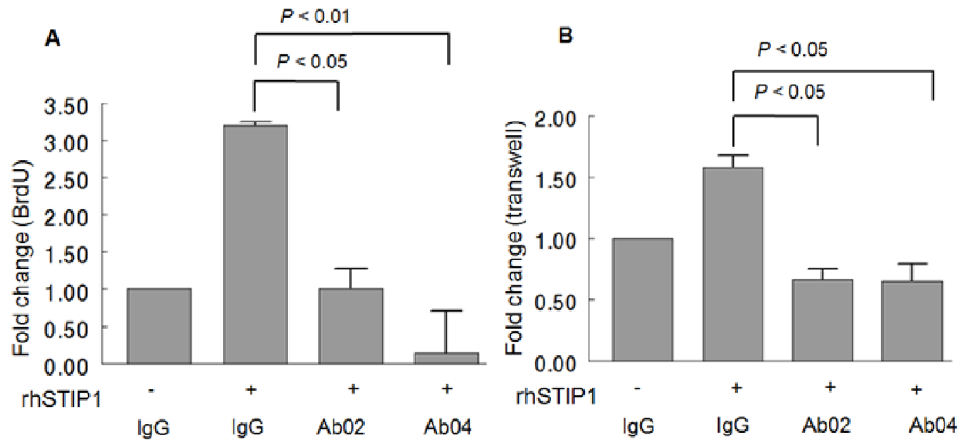
Figure 6. The effects of recombinant human STIP1 (rhSTIP1) on ovarian cancer cells are neutralized by the co-treatment with anti- STIP1 antibodies. When anti-STIP1 antibodies (800 nM) were added to cancer cells previously exposed to 400 nM of rhSTIP1, cell proliferation (A) and migration (B) were inhibited. Data are presented as means 6 standard errors of the means of three independent experiments.